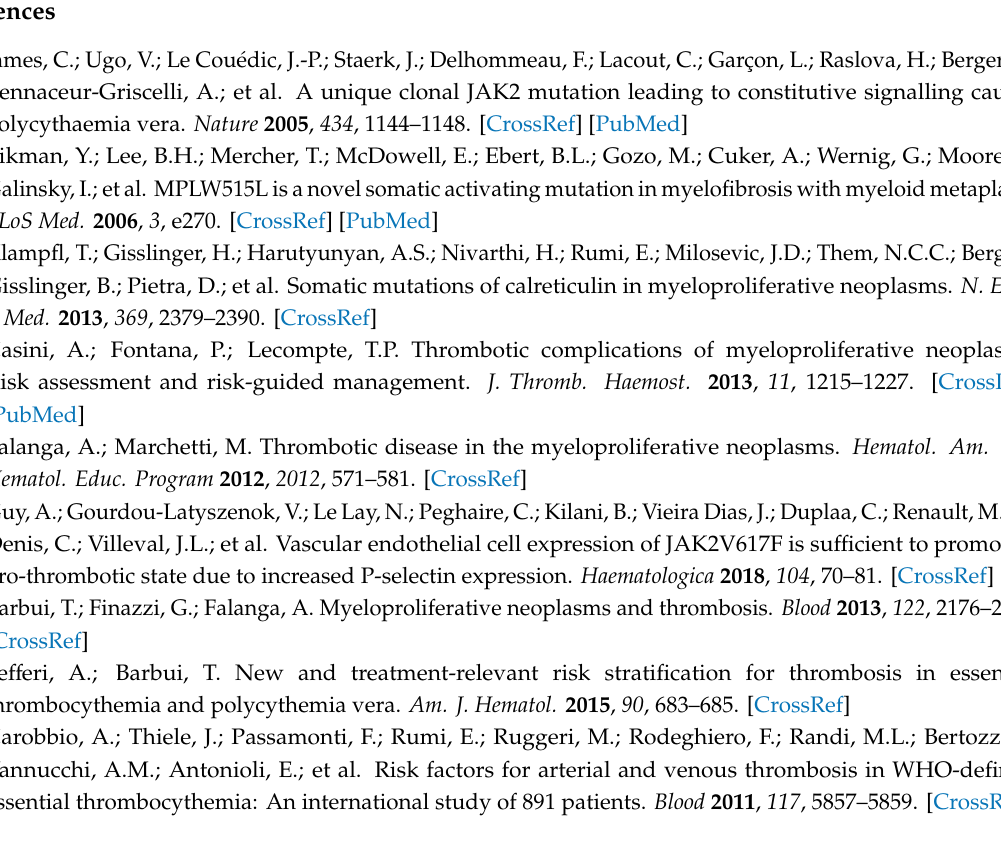
Table S1: Biological characteristics of ET and PV patients, Table S2: Biological resistance to aspirin according to treatment